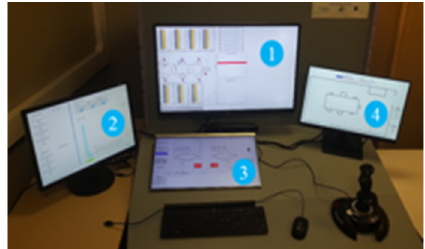
Figure 3. Workplace to control the intelligent manufacturing system (Organization 1). (1) Produc- tion control interface; (2) Planning interface; (3) Logistics control interface; (4) Tactical interface.